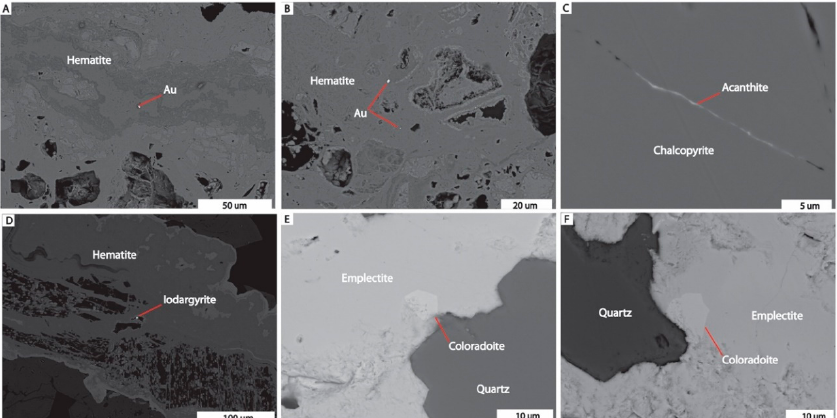
Figure 7. FE-SEM images of Au nano-sized inclusions, Ag-bearing minerals, and coloradoite; ( A ) and ( B ) nano inclusions of Au in iron oxyhydroxides; sample from the supergene zone; ( C ) Acanthite filling fracture in chalcopyrite; sample from the sulfide zone; ( D ) Iodargyrite filling cavities in iron oxyhydroxides; sample from the oxide mineralization zone; ( E , F ) Coloradoite in intergrown texture with emplectite along grain boundary with quartz; sample from the sulfide zone.